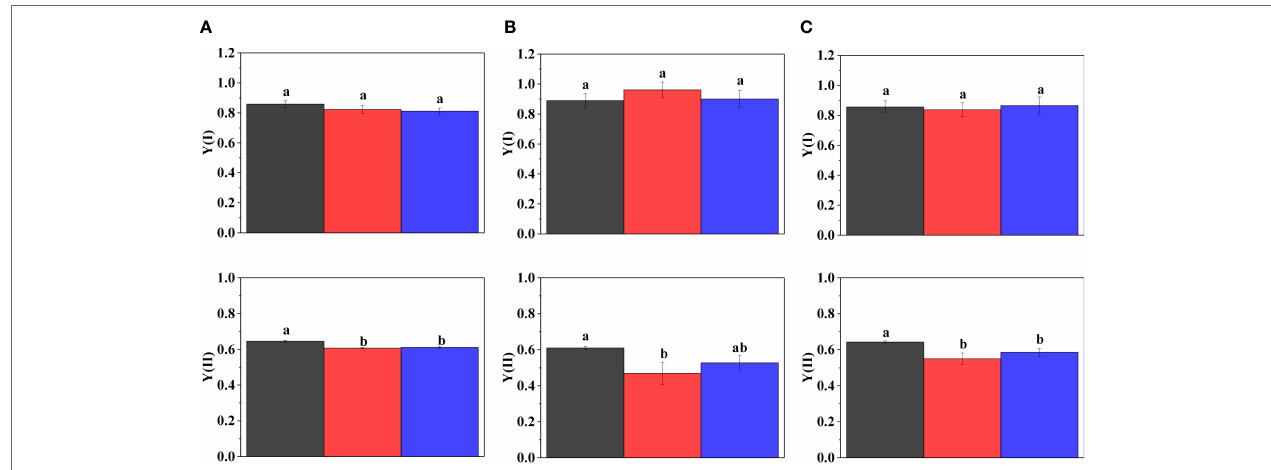
FIGURE 3 | Activity of PSI ((Y(I)), upper panel) and PSII ((Y(II), lower panel) in three different strains of Symbiodiniaceae under elevated temperatures. (A) Fugacium kawagutii (CS156), (B) Symbiodinium tridacnidorum (2465), and (C) Symbiodinium microadriaticum (2467), including control (black), 34°C 2 h (red), and recovery (blue). Different letters above the bars indicate statistically different means (mean values of three biological replicates ± S.D.), and values sharing common letters are not significantly different from one another (p <